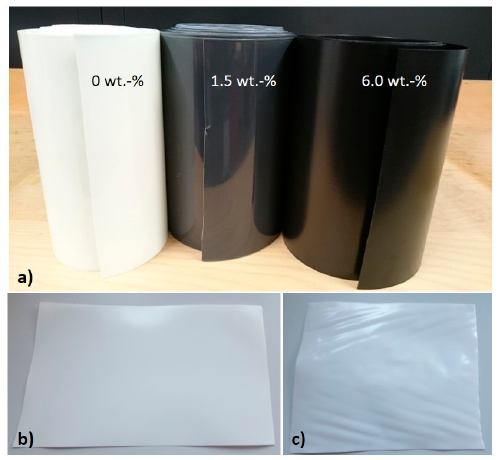
Figure 1. Rolls of extruded films with different filler content. ( a ) A piece of extruded film with 0 wt.-% filler before thermal treatment, and ( b ) after thermal treatment at 120 °C ( c ).